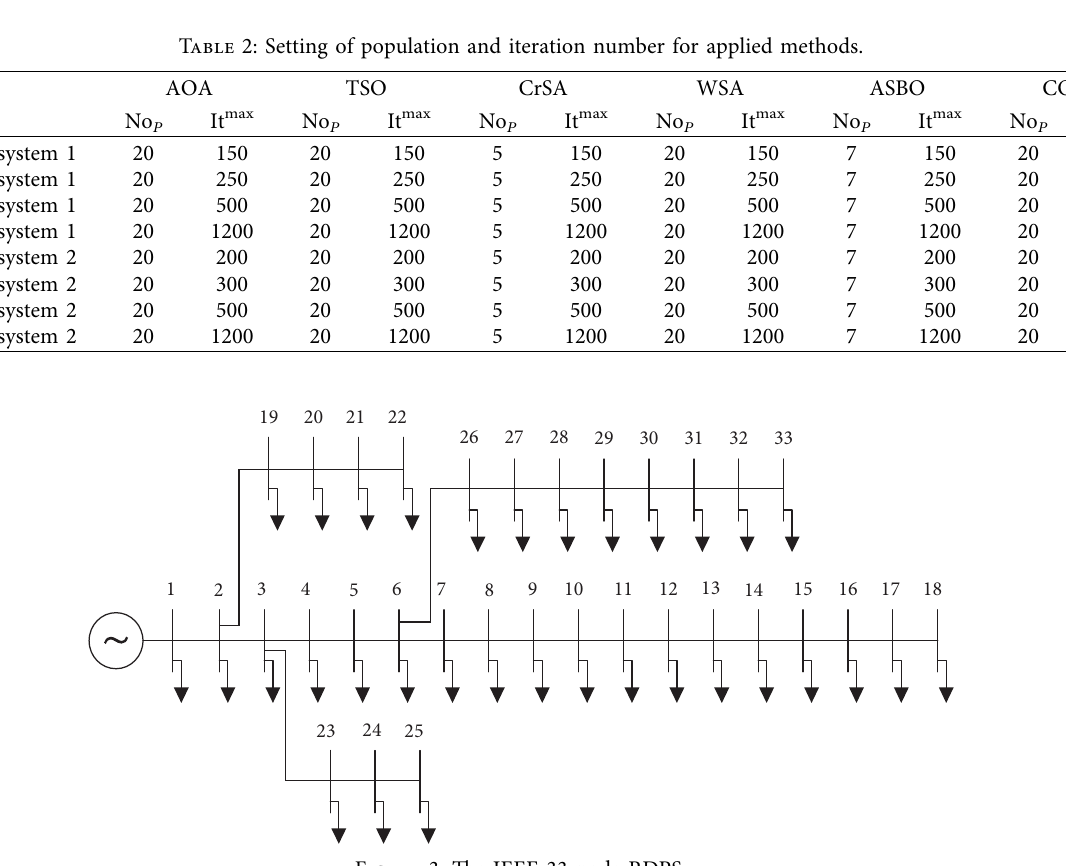
Figure 3: Te IEEE 33-node